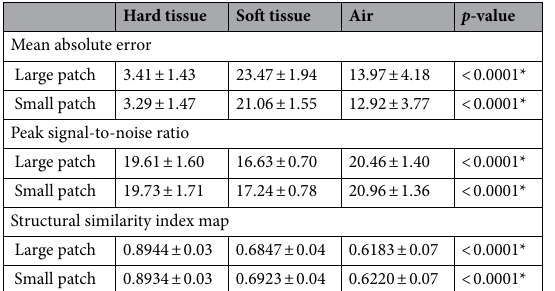
Table 3. Image quality evaluation metrics based on hard tissue, soft tissue, and air evaluation of the image. *One-way ANOVA with 95% confidential